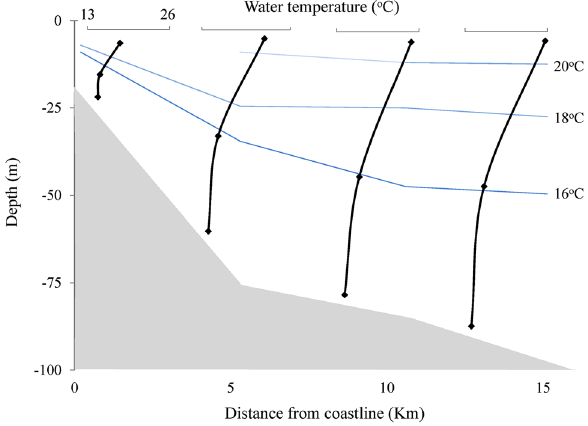
Figure 2. Temperature of the longitudinal samples from the surface, middle, and bottom of the water column.